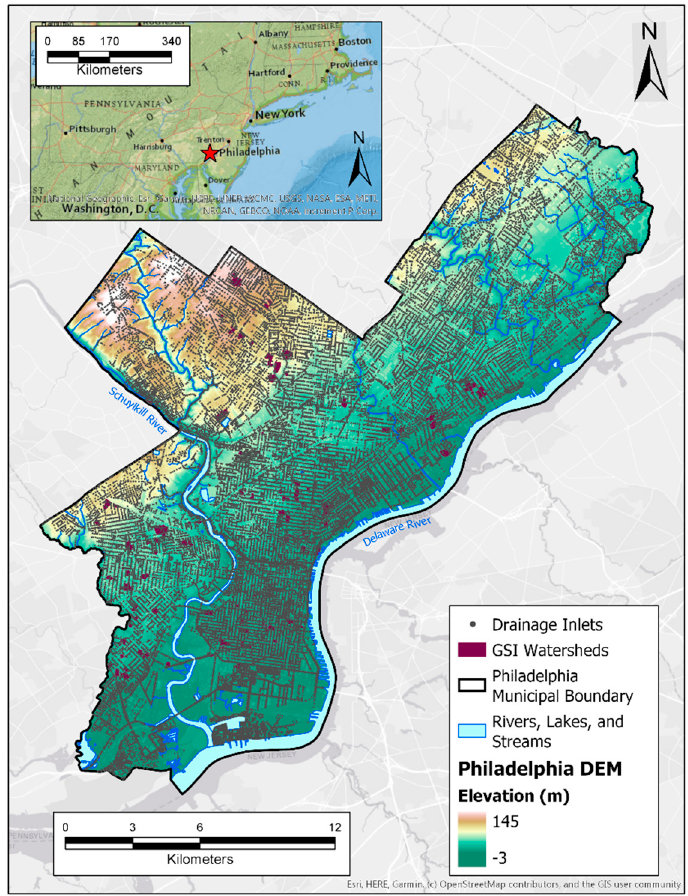
Figure 1. The study area of this research is limited to the City of Philadelphia, PA.